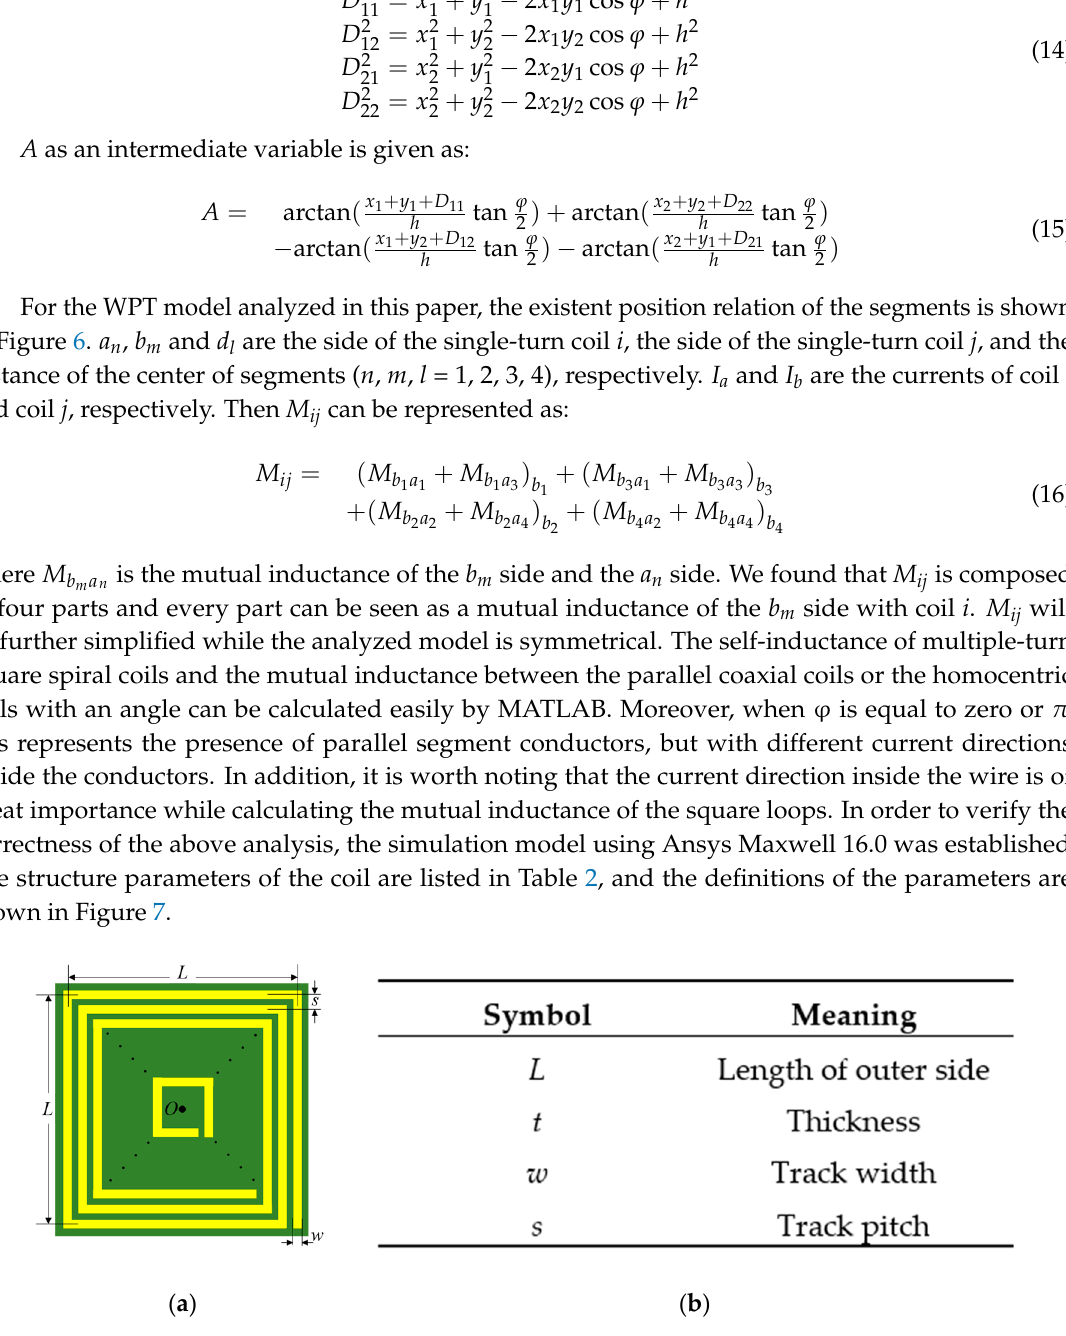
Figure 7. Simulation model diagrammatic drawing: ( a ) structure, ( b ) explanation of the